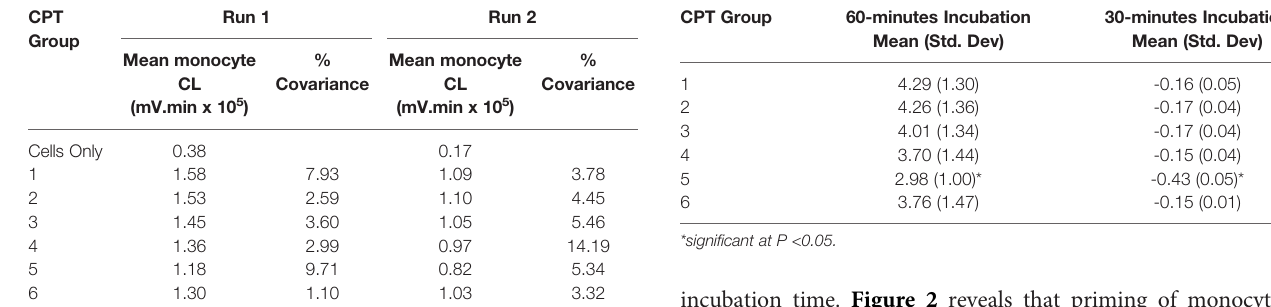
TABLE 4 | Monocyte CL for run 1 and run 2. PMA 10 -5 M, luminol 10 -6 M, 60- minutes priming and 60-minutes post-activation. CPT Run 1 Group